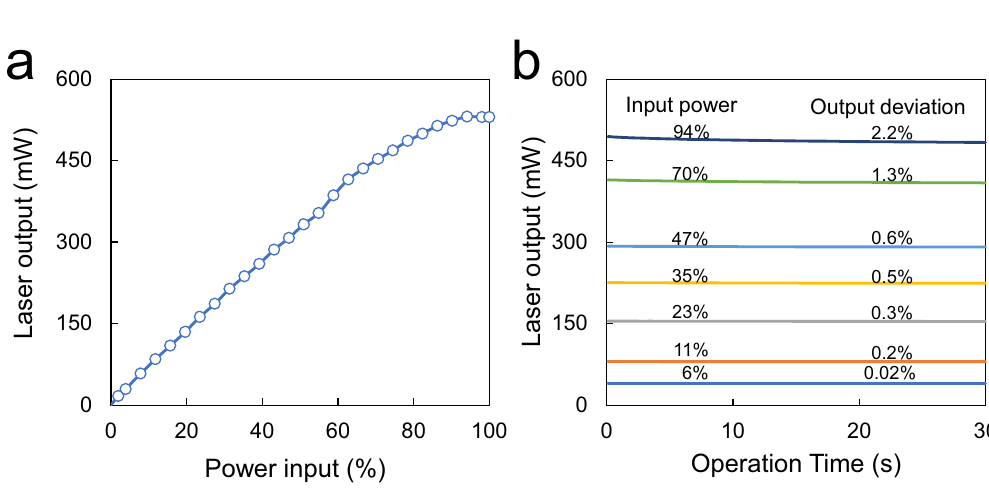
Figure 3. Characteristics of laser output power against input signals: ( a ) Laser output against PWM input ratios and ( b ) laser output fluctuations at various PWM ratios in the “on” state for 30